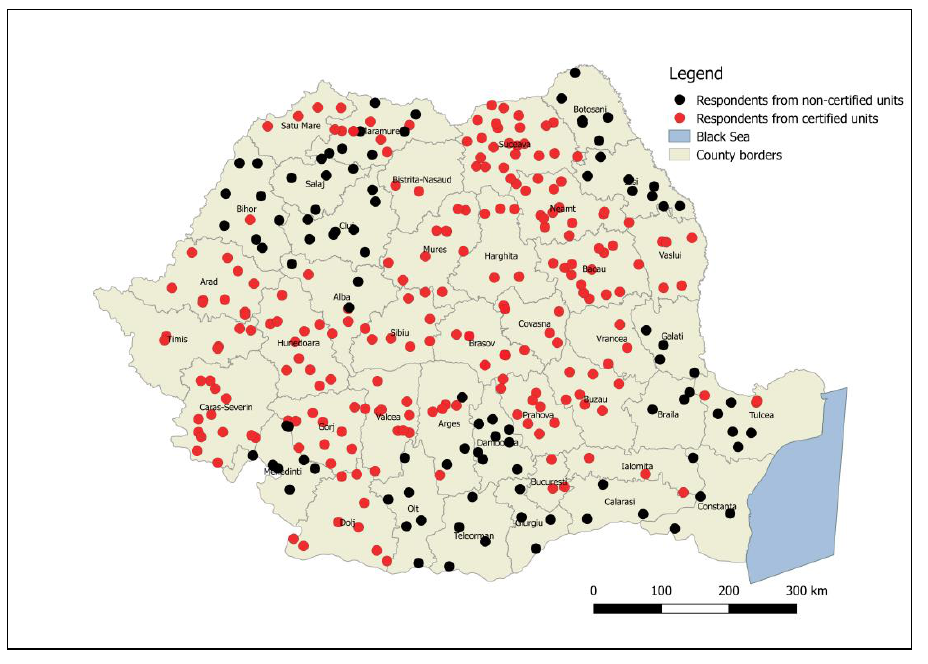
Figure 1. Map of Forest District respondents—certified and uncertified units. Table 2. Surveyed population and response rate.